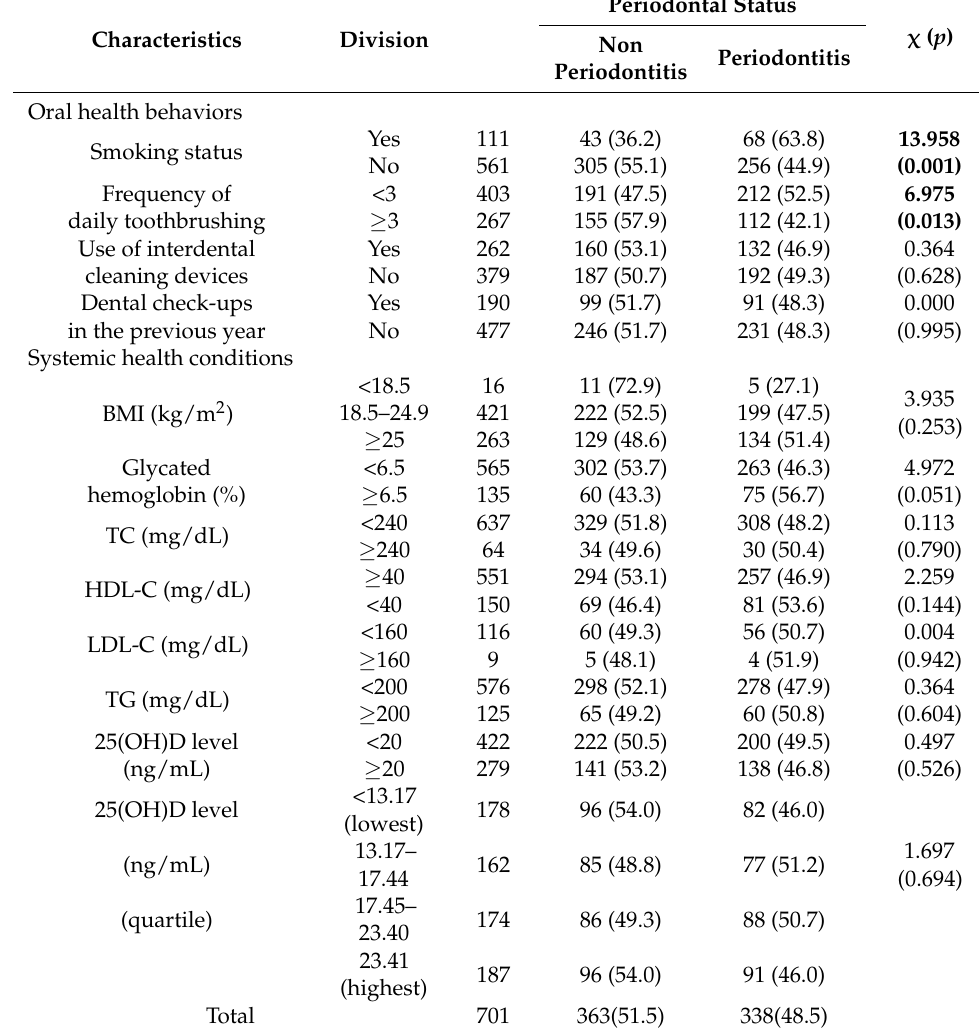
Table 1. Associations between oral health behaviors or systemic health conditions and periodontitis.